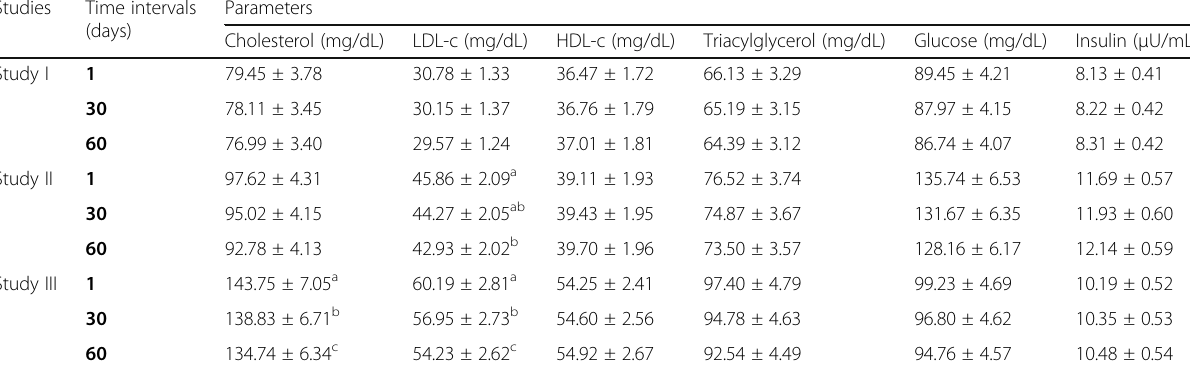
Table 3 Effect of time intervals on lipidemic and glycemic parameters of rats in different studies Studies